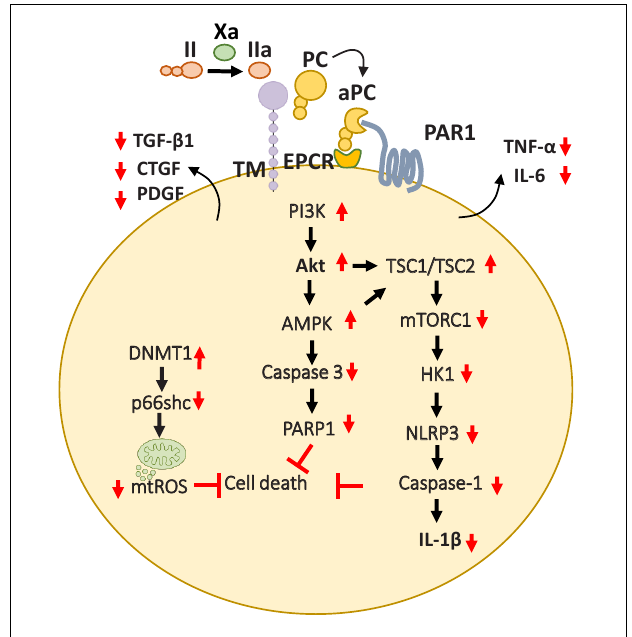
FIGURE 5 | Overview of cytoprotective signaling mechanisms in the myocardium. aPC triggers a complex signaling network of PI3K thereby inhibiting cell death and promote cardioprotection by preventing the mitochondrial ROS and pro-apoptotic as well as inflammasome associated caspases described in multiple cell types of the myocardium. Additionally, aPC has been shown to prevent the release of pro-inflammatory cytokines (TNF- α , IL-6) as well as pro-fibrotic factors (TGF- β , CTGF, PDGF) from the myocardium. Bottom pointing red arrows, downregulation; Upward pointing red arrows, upregulation; Black arrows, pathway